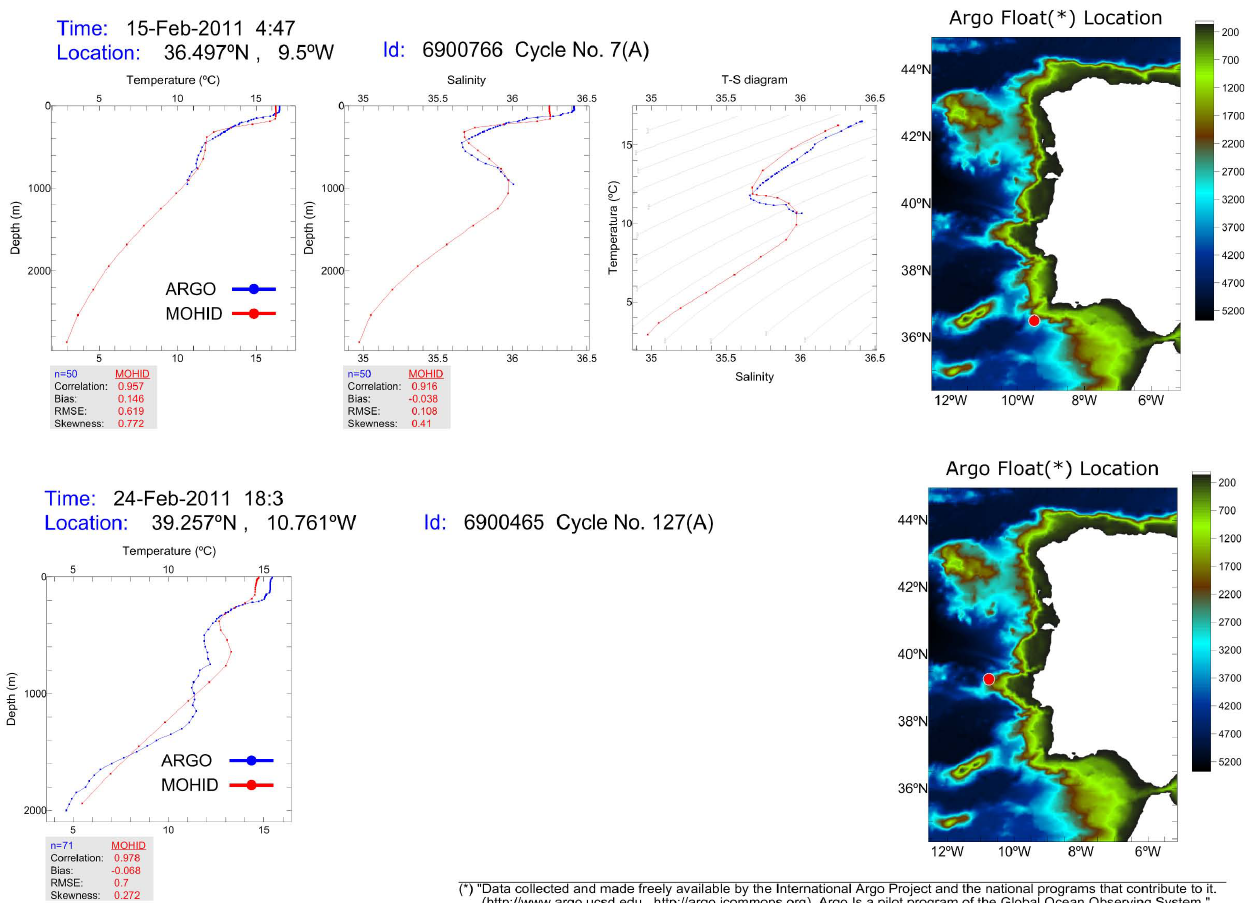
Fig. 10. Simulated temperature and salinity profiles for February 2011 compared with Argo data. The locations of the buoy are represented in the maps by a red circle. Statistical results are also present for each